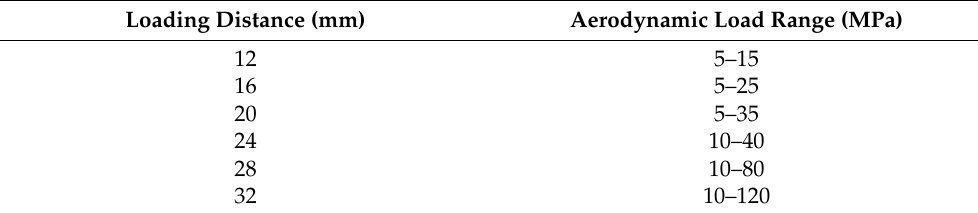
Table 2. Range of the aerodynamic loads at different loading distances.